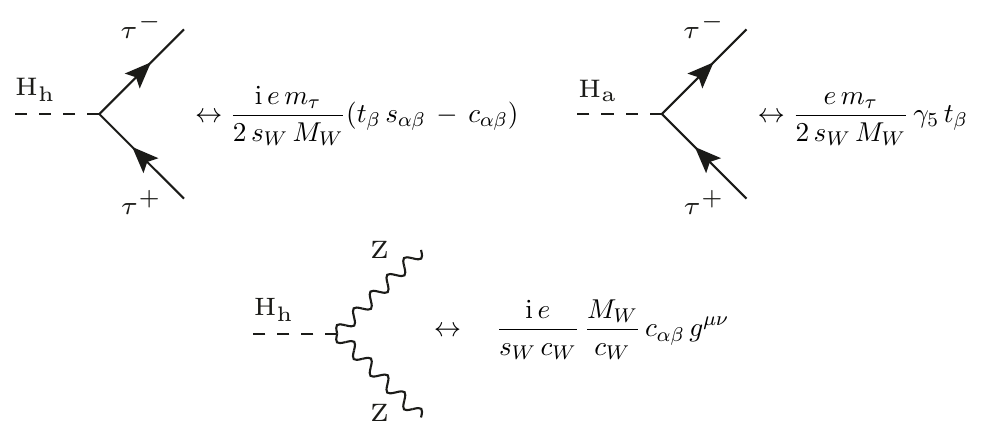
p 1 c 2 . W (cid:0)